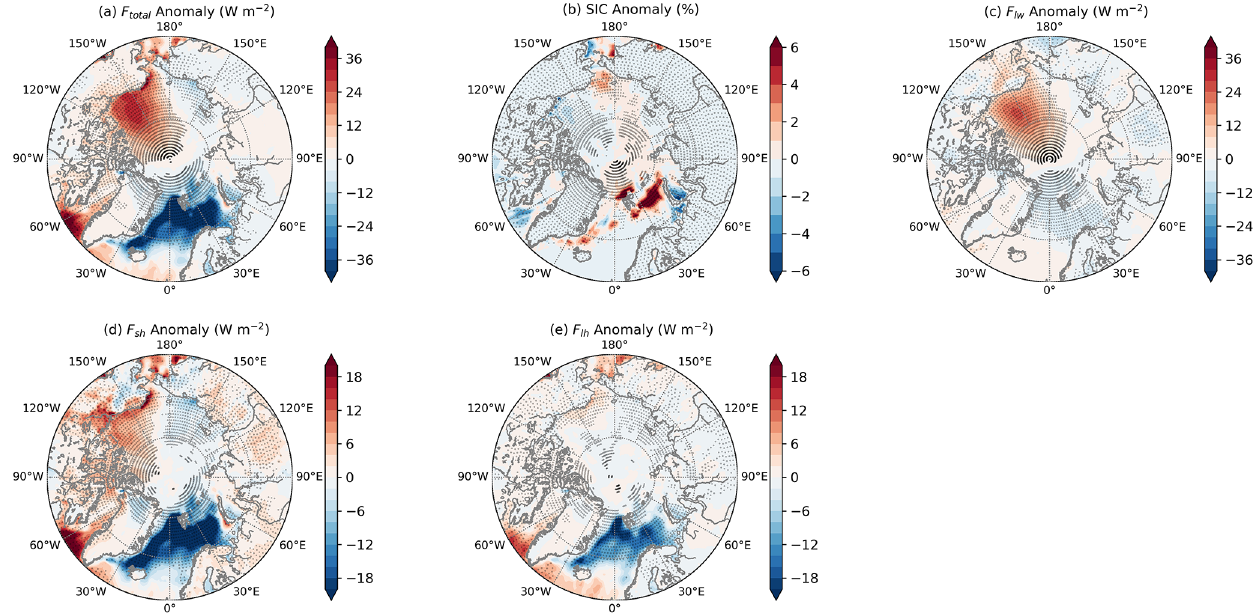
Figure 6. Composite ERA5 anomalies of (a) total surface energy (Wm − 2 ), (b) sea-ice concentration (%), (c) surface thermal net irradiance (Wm − 2 ), (d) surface sensible heat flux (Wm − 2 ), and (e) surface latent heat flux (Wm − 2 ) for all EMIs over the Beaufort Sea, during 1979– 2018 winter. Noted that the color-bars here are different than those in Fig. 5. The stippling indicates statistical significance at the p < 0 . 01 level from a Student’s t